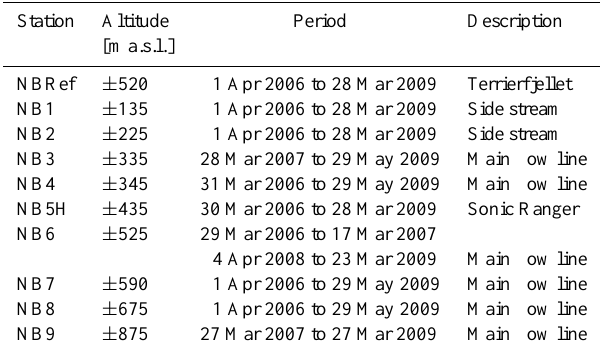
Table 1. Characteristics of the different GPS stations on Norden- ski¨oldbreen, Svalbard. Note that NB3 and NB9 were only active during the second year, while NB6 was lost in the second year. Station Altitude Period Description